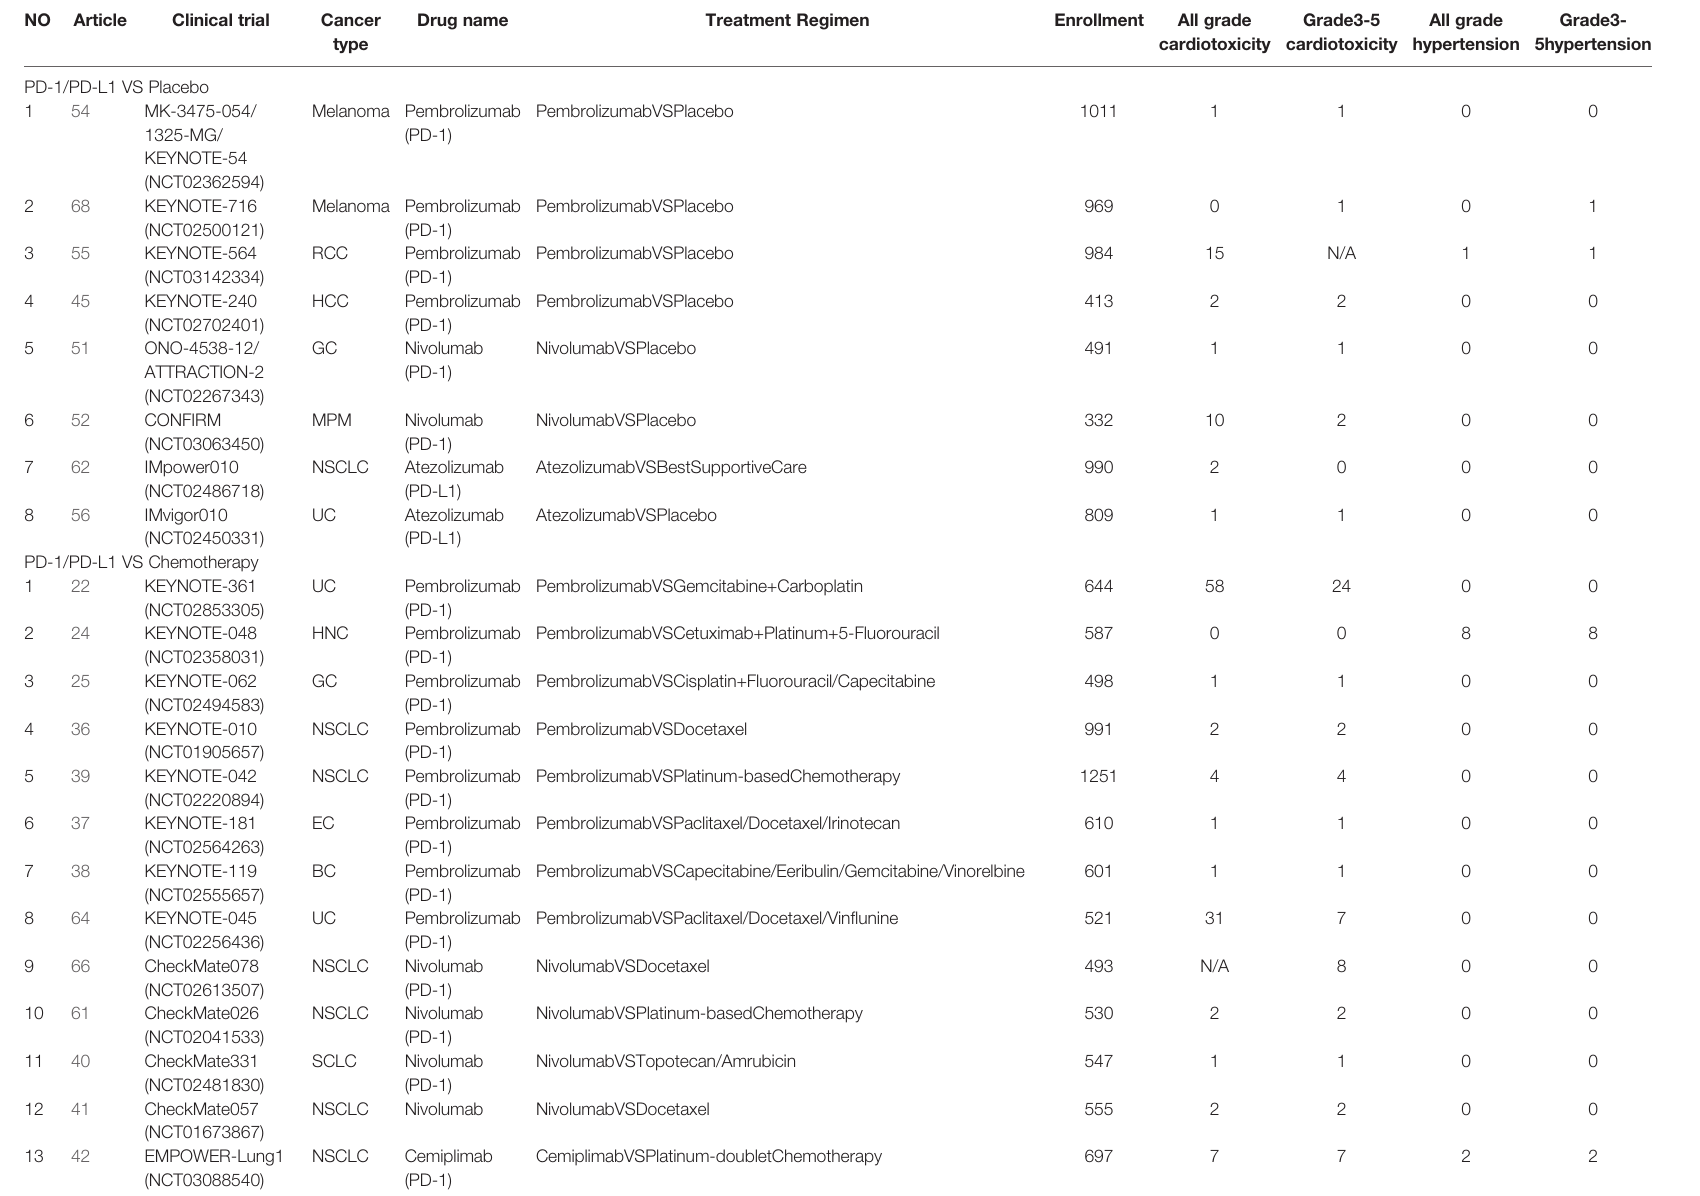
TABLE 1 | Characteristics of 50 studies included in analysis of cardiotoxicity and